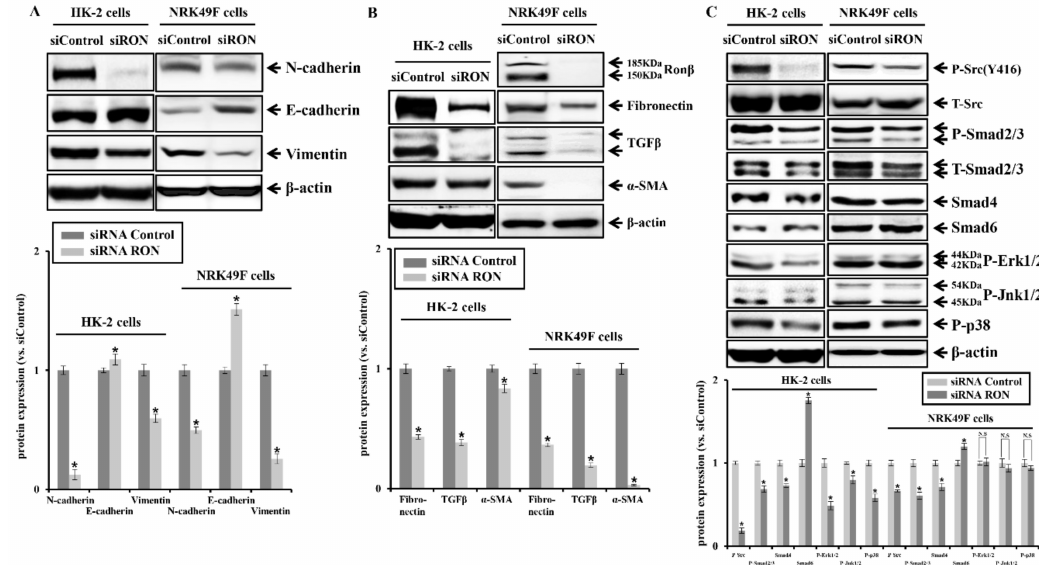
Figure 5. E ff ects of RON siRNA on EMT, pro-fibrotic marker, and the Src signaling pathway in HK-2 and NRK49F cells. ( A ) Protein expression of N-cadherin, E-cadherin, and vimentin by RON siRNA transfection was analyzed. ( B ) Protein expression of fibronectin, TGF β , and α -SMA by RON siRNA transfection was analyzed. ( C ) Protein expression of phosphorylated Src (Y416) was assessed in RON siRNA transfection and siControl. Protein expression of phosphorylated Smad2 / 3, Smad4, and Smad6 by RON siRNA transfection was analyzed. Protein expression of phosphorylated ERK (P-ERK), phosphorylated JNK (P-JNK), and phosphorylated P38 (P-p38) was assessed in RON siRNA transfection and siControl. Each column represents the mean ± SEM. * p < 0.05, compared with the siRNA control. N.S, statistically not